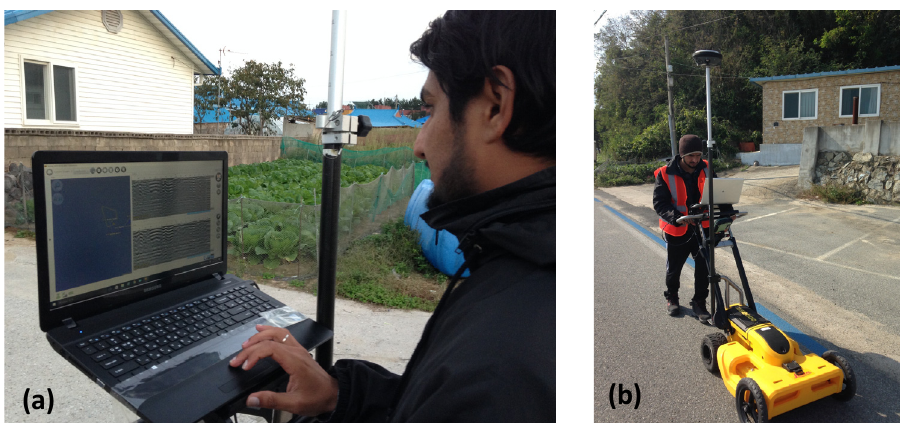
Figure 10. ( a ) Picture of electromagnetic radargram recording using overture software; ( b ) picture of conducting of the GPR survey using Leica GPR DS 2000.